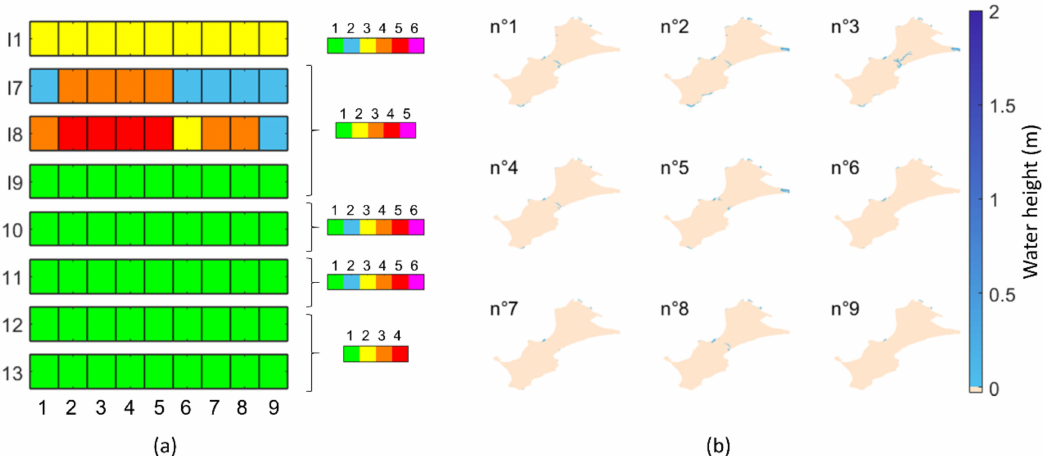
Figure 14. Results from the numerical simulations of the nine events identified in Figure 13b (such that C(I 1 ) ≥ 3 based on the meta-models and post-processing outputs). ( a ) Indicators directly computed from the numerical hydrodynamic simulations without any post-processing; ( b ) maximal water height (m) computed from the numerical output over 6 h with a time step of 1 min. The respective flood surface areas (m 2 ) in panel ( b ) are 5589, 12,006, 13,860, 3465, 8208, 2070, 2088, 4167, and